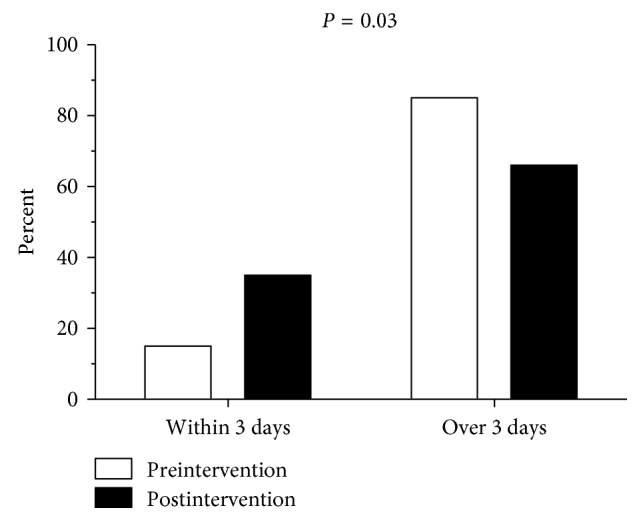
Comparison of the times to antimicrobial susceptibility of the preintervention and postintervention groups.